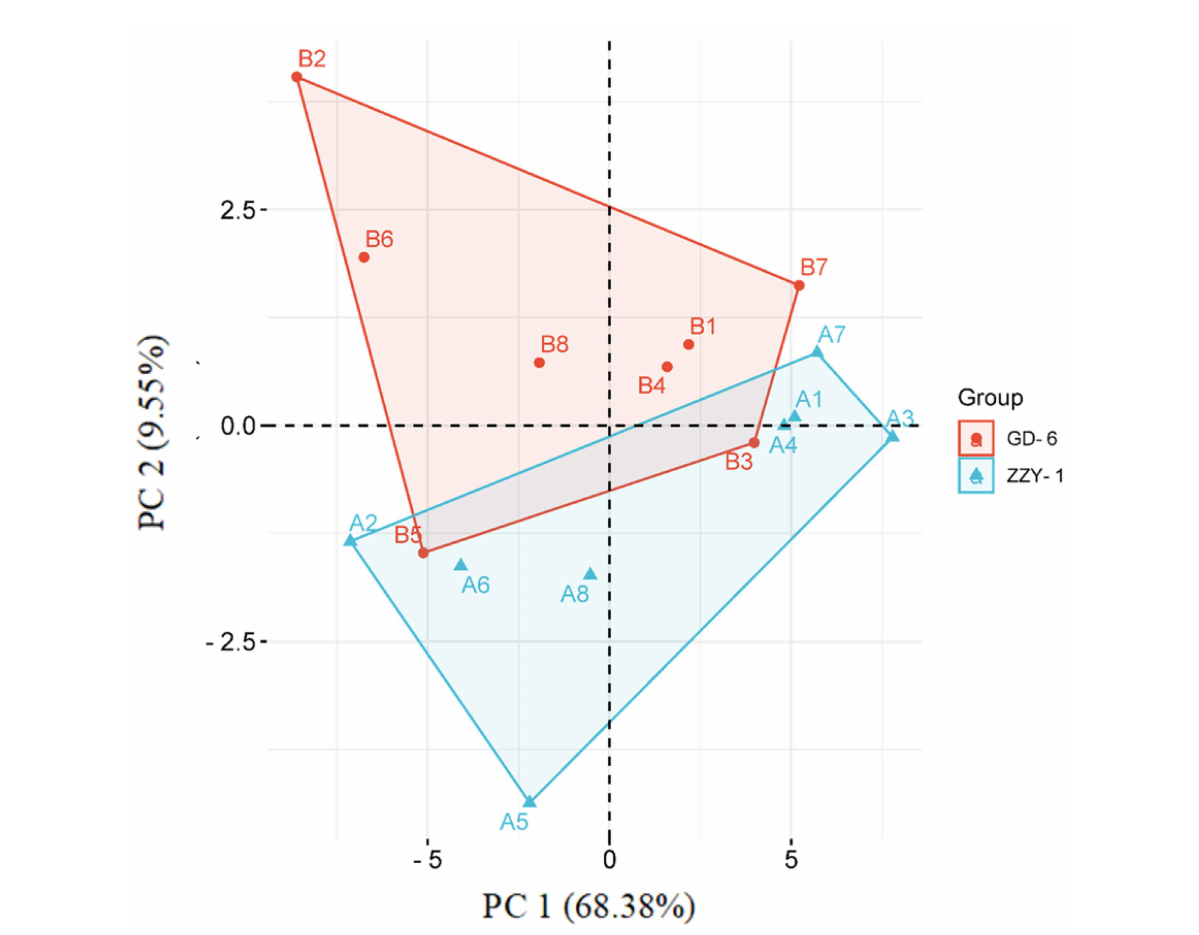
FIGURE 7 A PCA-contingent biplot of measured physio-biochemical parameters under alone and combined Serendipita indica symbiosis and phosphorus application. Key: A = ZZY-1 genotype; B = GD-6; numbers 1 to 8 correspond with CK, As, S.i , P, S.i + As, P + As, S.i + P, and S.i + P + As, respectively. Sh, Shoot/leaves; R,